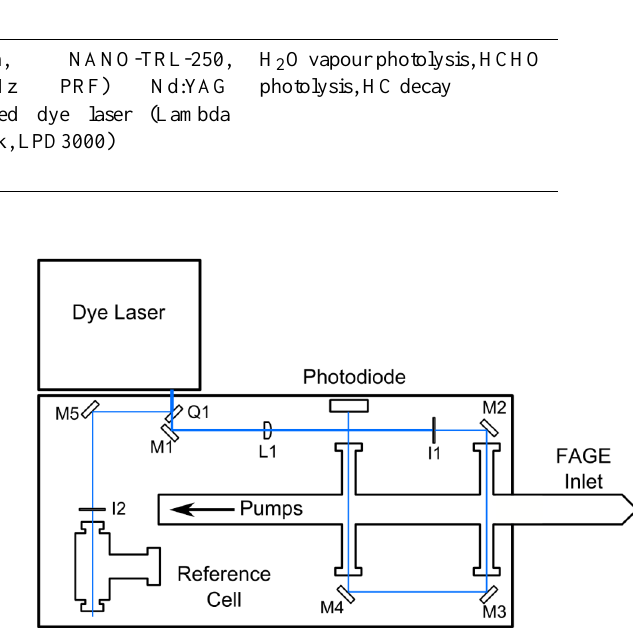
Figure 2. Top-down schematic of the FAGE instrument showing the laser beam path (blue line) through the OH and HO 2 detection cells, and the reference cell using the Litron/LPD3000, 200Hz PRF laser source. Q – quartz flat; M – mirror; I – iris; and L – lens. The FAGE inlet is extended past the edge of the mounting table for insertion into the HIRAC chamber. The calibrated photodiode was used to normalise the fluorescence signals to fluctuations in laser